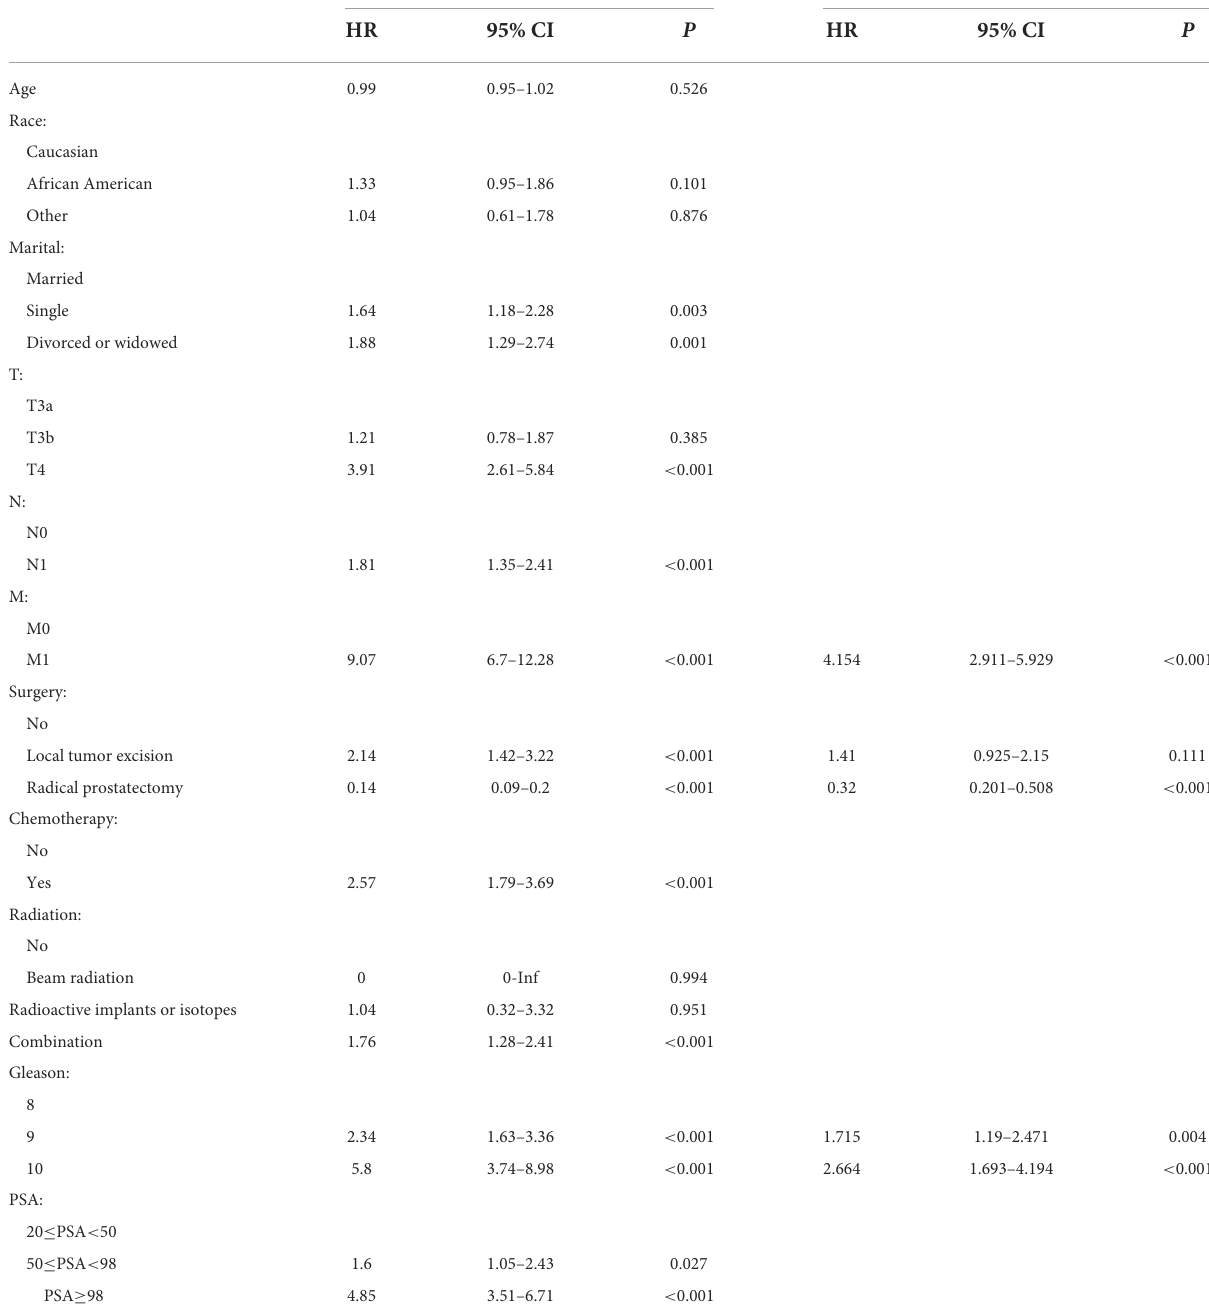
TABLE 2 Univariate and multivariate analyses of CSS in training cohort. Univariate